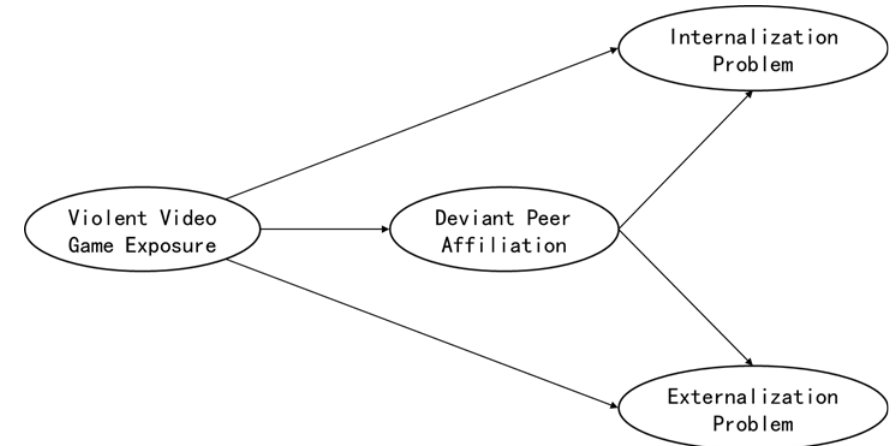
Figure 1. Hypothesized model of violent video games affecting problem behavior.